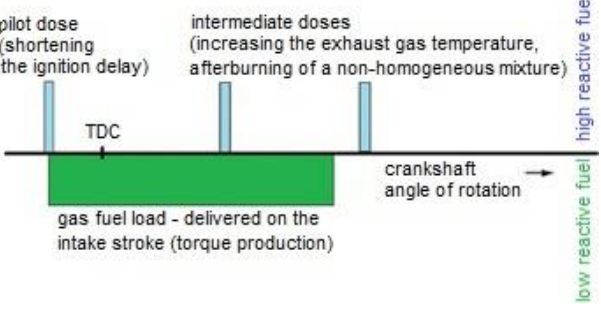
Fig. 5 Diagram of the co-combustion strategy with the use of multiple fuel injection (based on [1, 2,